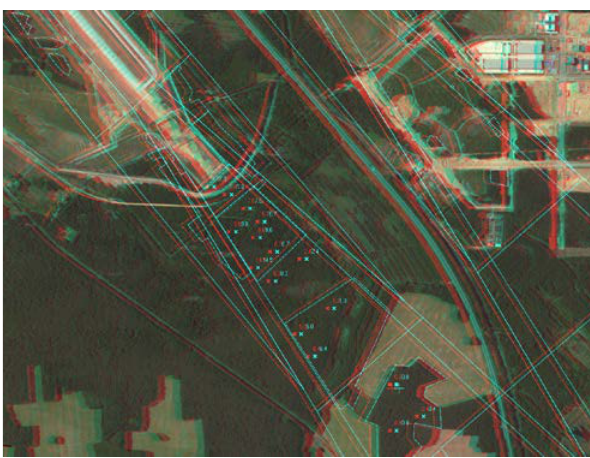
Figure 1. The ADS-100 stereo image (2018) To prepare the images for photogrammetric measurements, they were geo-positioned using ground control points or exterior orientation elements according to their technical characteristics (Table 1).